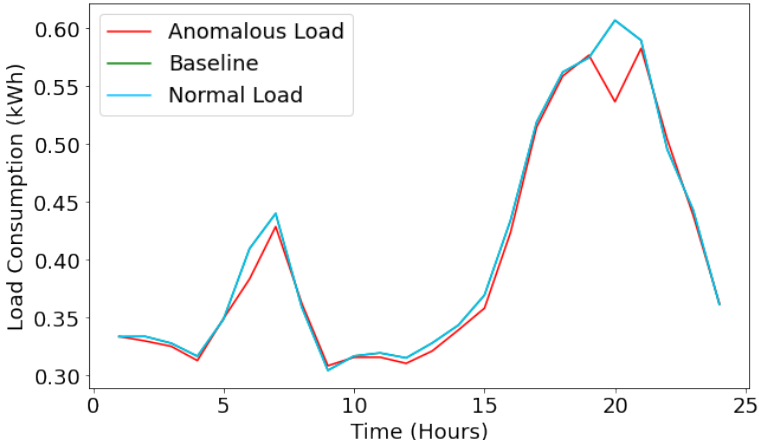
Figure 11. Energy loss prediction for miscellaneous